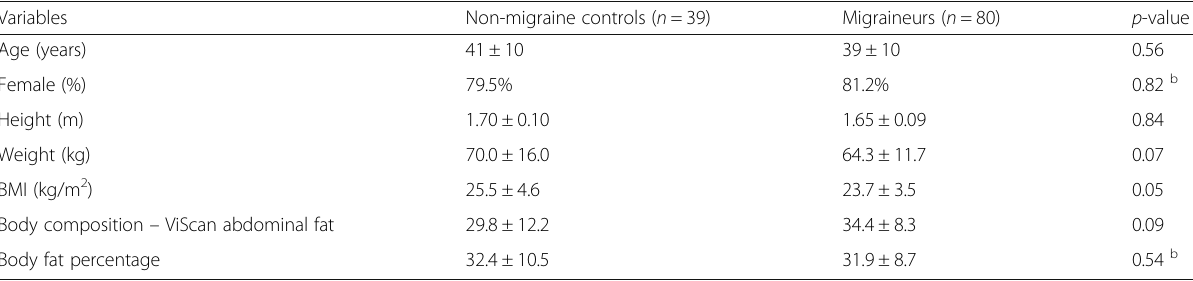
Table 1 Anthropometric characteristics of migraine patients versus non-migraine controls